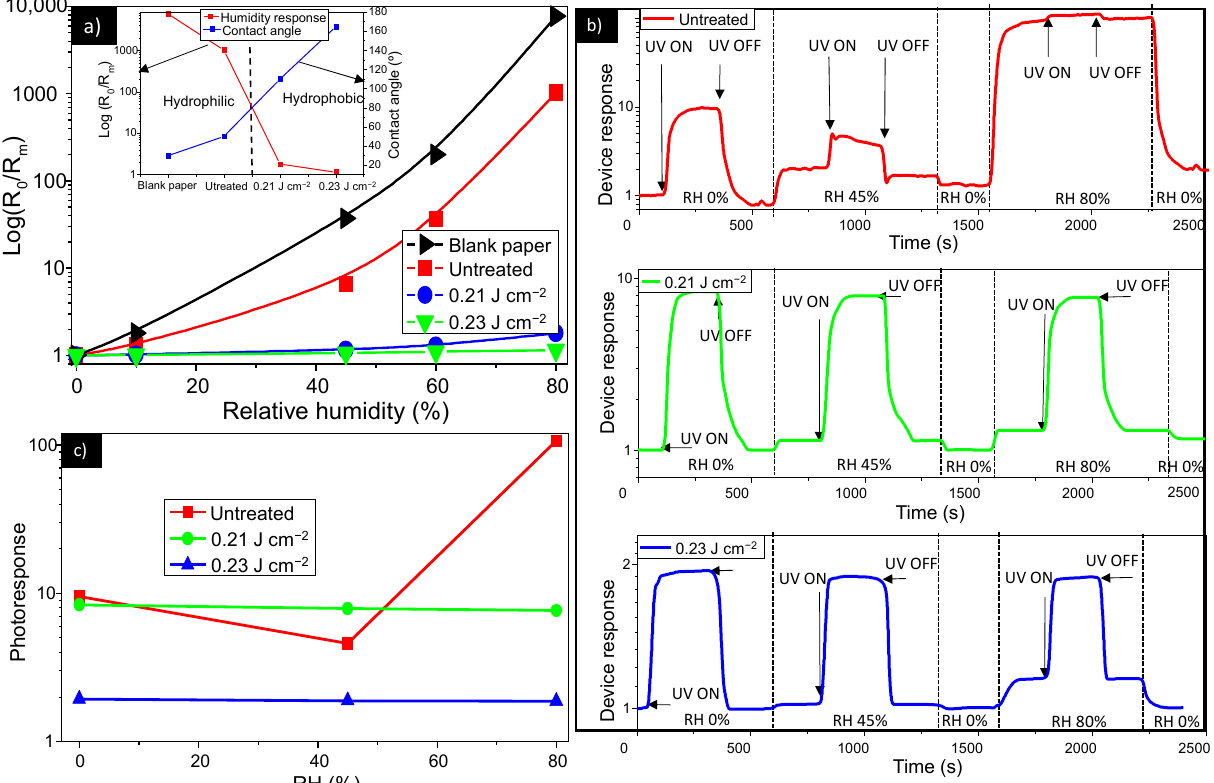
Figure 6. ( a ) Electrical resistance changes for the untreated and laser treated devices as a function of RH (Relative Humidity). Inset: Humidity response at 60% and contact angle as a function of the laser fluence. ( b ) Dynamic response of untreated and treated ZnO sensor to UV light at various humidity levels. ( c ) Photoresponse of the untreated and laser treated samples as a function of RH.